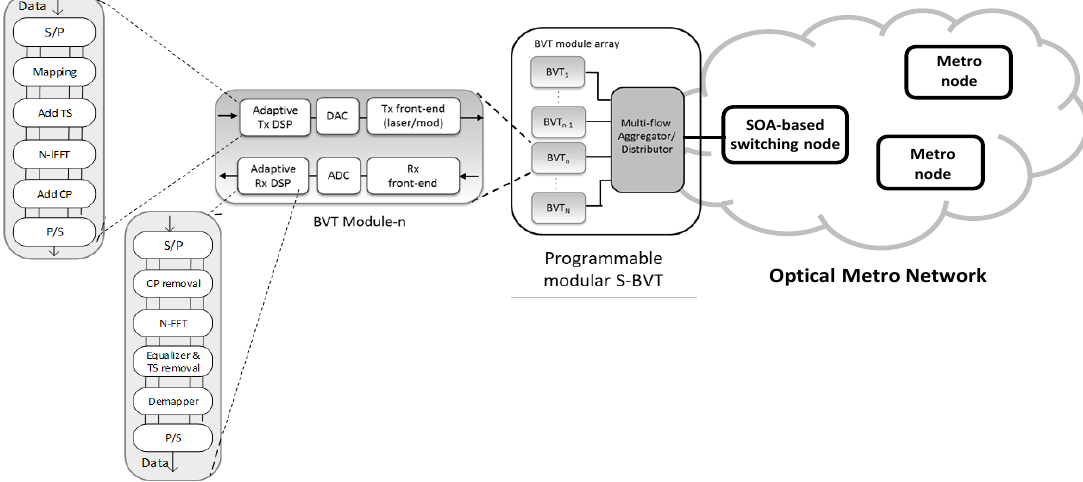
Figure 1. S-BVT architecture based on adaptive DSP using DMT for optical metro networks with SOA-